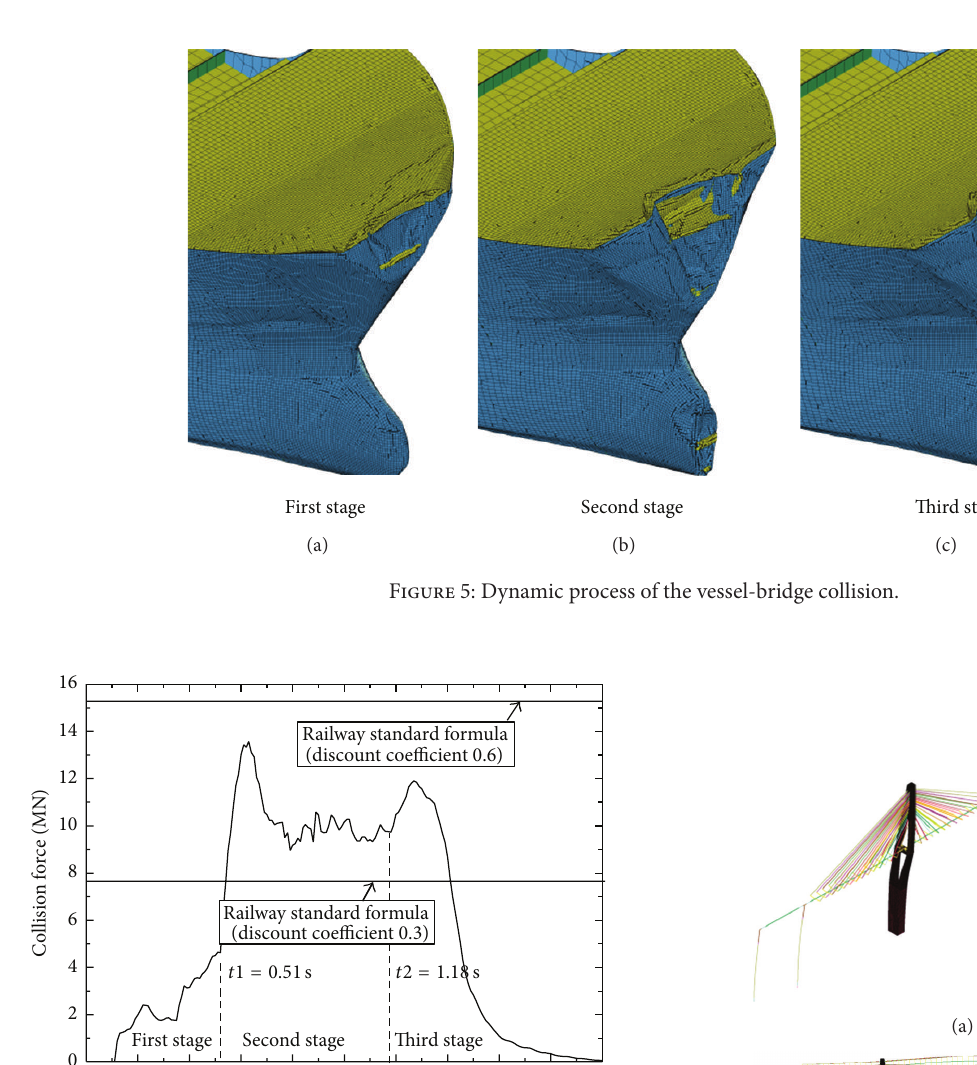
Figure 4: FEM for the vessel-bridge collision.